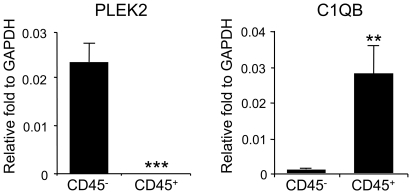
Expression of PLEK2 and C1QB in fractionated blood.Freshly collected blood cells were fractionated into CD45+ and CD45- cells using whole blood CD45 kit, and analyzed by standard qRT-PCR. Expression of PLEK2 and C1QB was normalized to the housekeeping gene GAPDH. Data represent results from 6 healthy individuals. The data are shown as the means ± S.E. (n = 6). **, p<0.01; ***, p<0.001 compared with CD45− subpopulation.